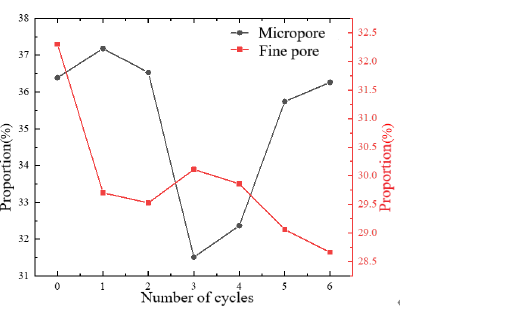
Figure 4. T 2 distribution before and after freeze–thaw cycles.